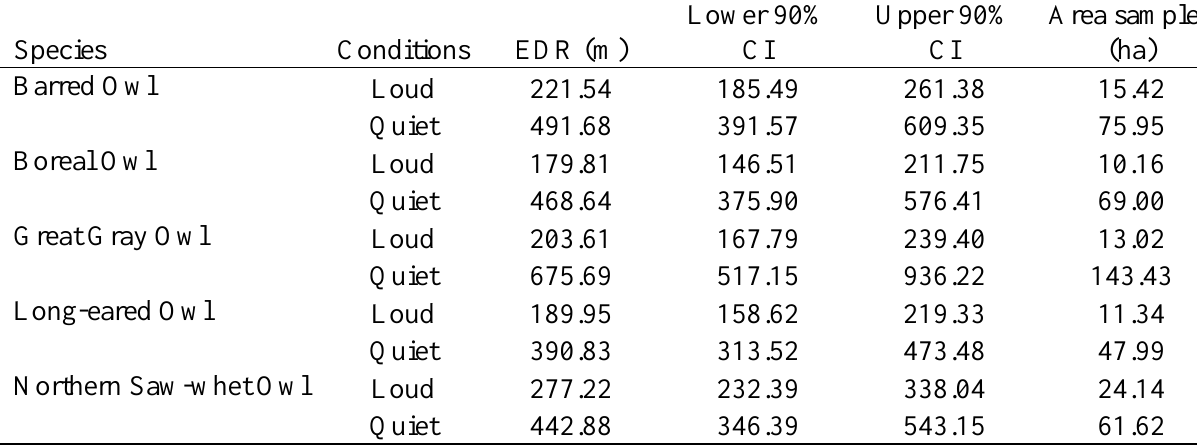
Table A1.1. Estimated effective detection radius (EDR), lower and upper 90% confidence intervals (CI) and the estimated area sampled by an autonomous recording unit (ARU) for the territorial calls of five species of owls in loud and quiet